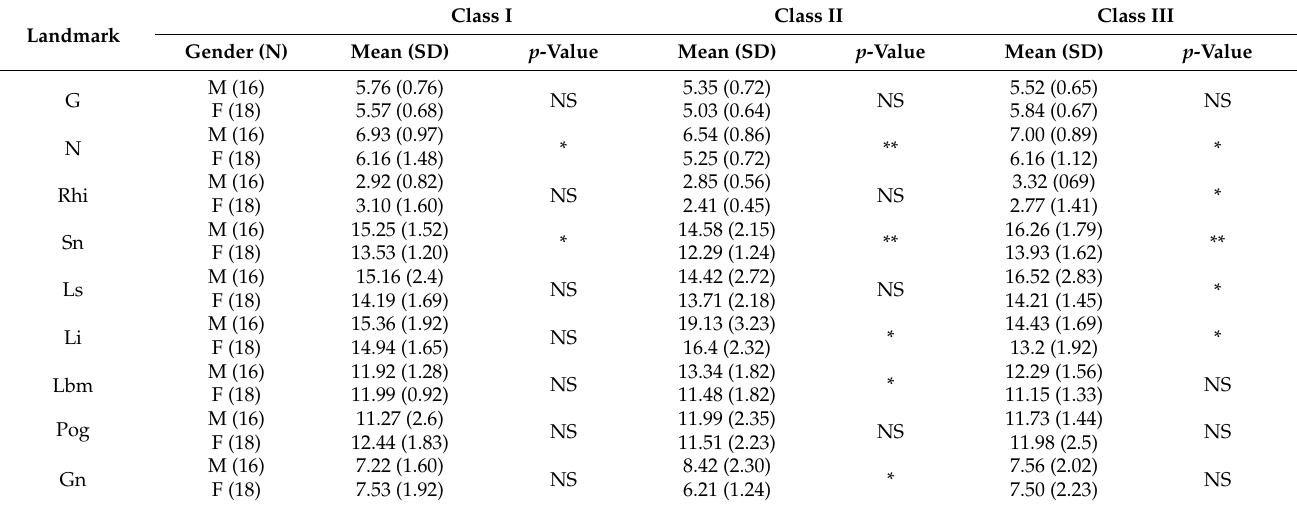
Table 3. Mean, SD of Korean population (mm) among three skeletal